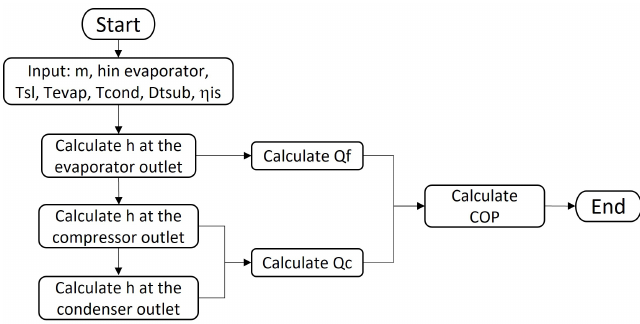
Figure 3. Flow chart of the simulation program of the